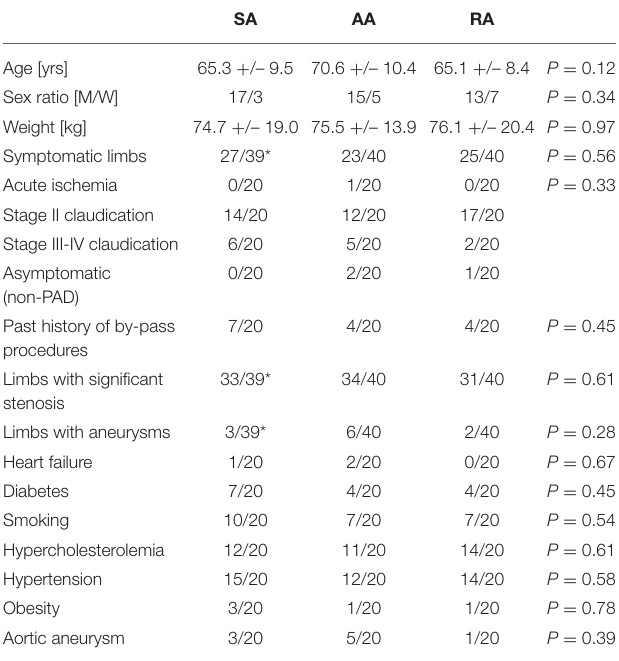
TABLE 1 | Demographic details and characteristics of patients by groups of